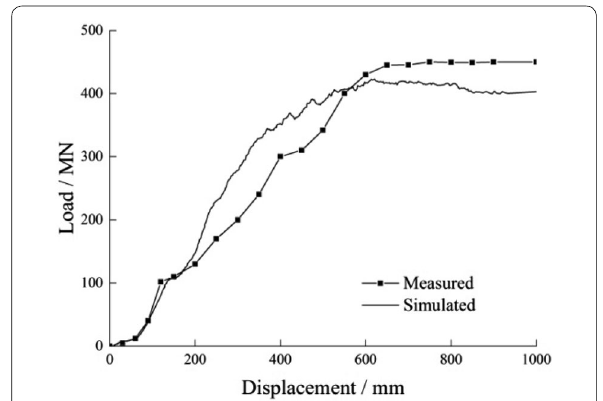
Figure 15 Comparisons of displacement—load curves between measured and